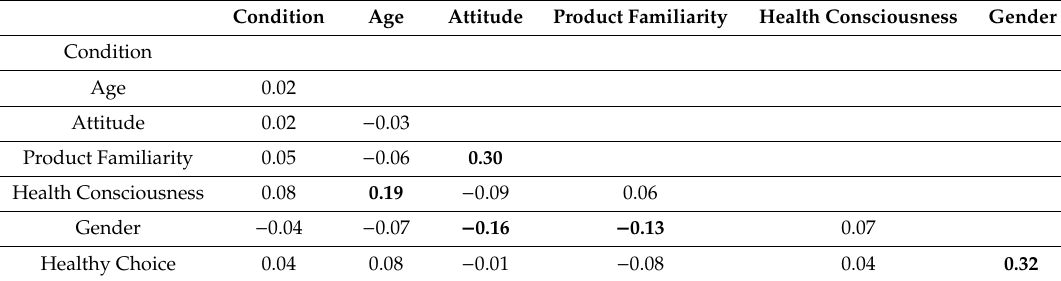
Table 2. Correlation matrix of predictor and outcome